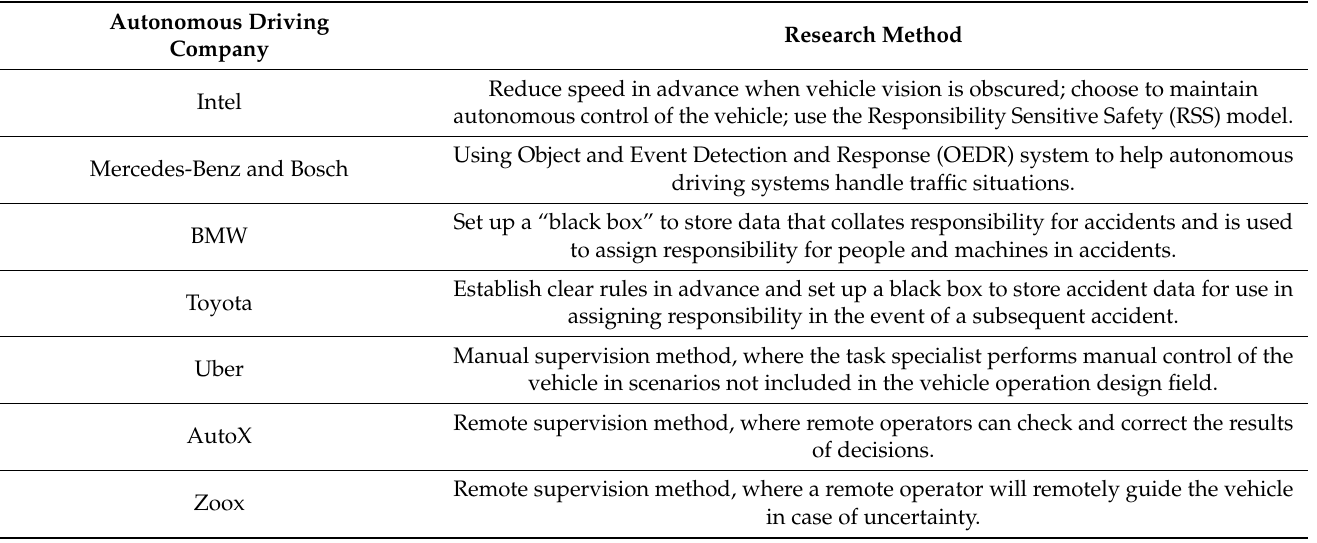
Table 1. Research advances in moral dilemmas for autonomous driving companies. Autonomous Driving